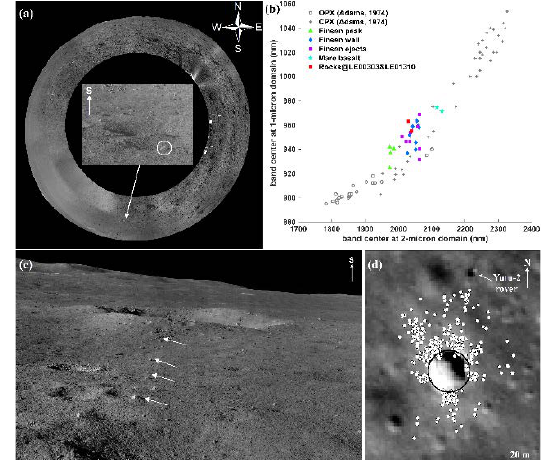
Figure 8. (a) Pancam mosaic generated from images acquired during the 13th lunar day. The rock fragment that was spectrally measured is indicated by the white circle. (b) Comparison of absorption band centers for different materials. (c) Pancam mosaics of the 15-m elliptical fresh crater with a blocky rim. (d) The spatial distribution of rock fragments around the 15-m crater. Each white dot represents a rock fragment. (Gou et al.,